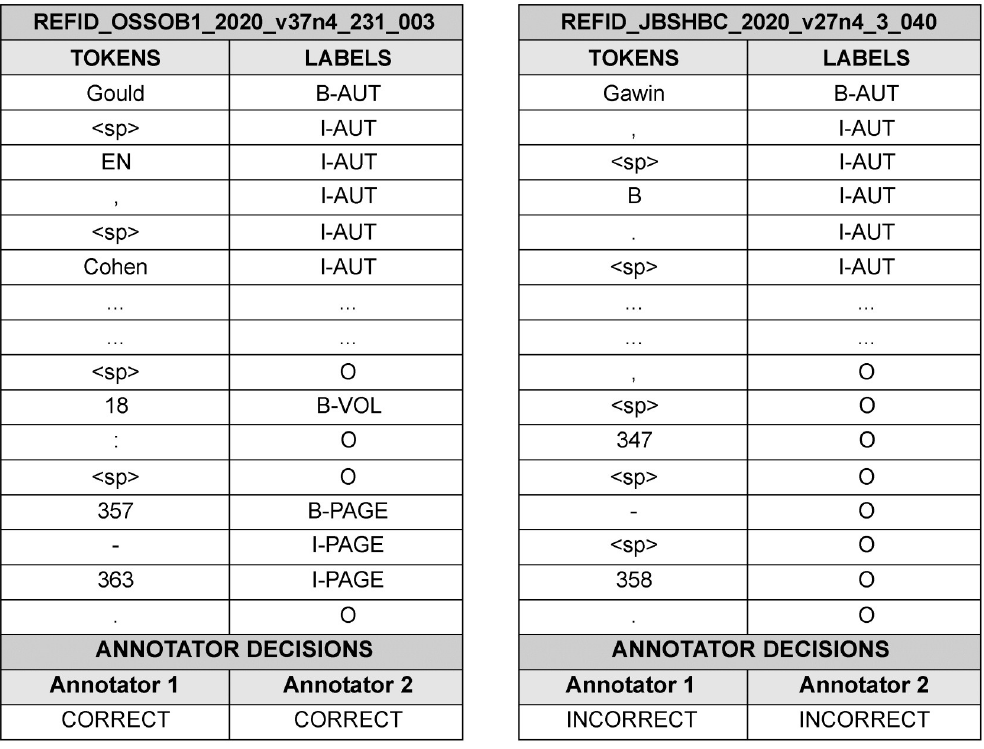
Fig 5. Sample of an Excel file used for inspection. For each reference, the first column represents the token sequence. The second column shows the IOB tags that were automatically assigned by string matching. The annotators wrote their decisions in the decision box on the last